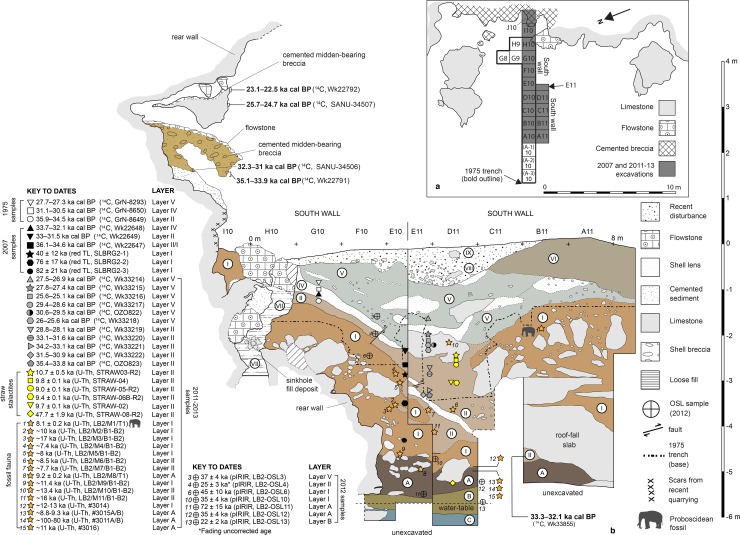
South wall stratigraphic profile at Leang Burung 2 (2011–13 excavations).The South Wall section illustrated here comprises a composite of two separate stratigraphic exposures, the southern trench faces of excavation squares E10-I10 and A11-E11, respectively, which are situated a distance of 1 m apart. With regards to 14C ages, all of the dated samples comprise freshwater gastropod (Tylomelania perfecta) shells; only dated shells collected in situ from the deposit are shown projected onto the stratigraphic profiles. The sampling locations for pIRIR samples LB2-OSL12 (Layer A) and LB2-OSL13 (Layer B) are not illustrated on the south wall profiles because they were collected from different trench faces.